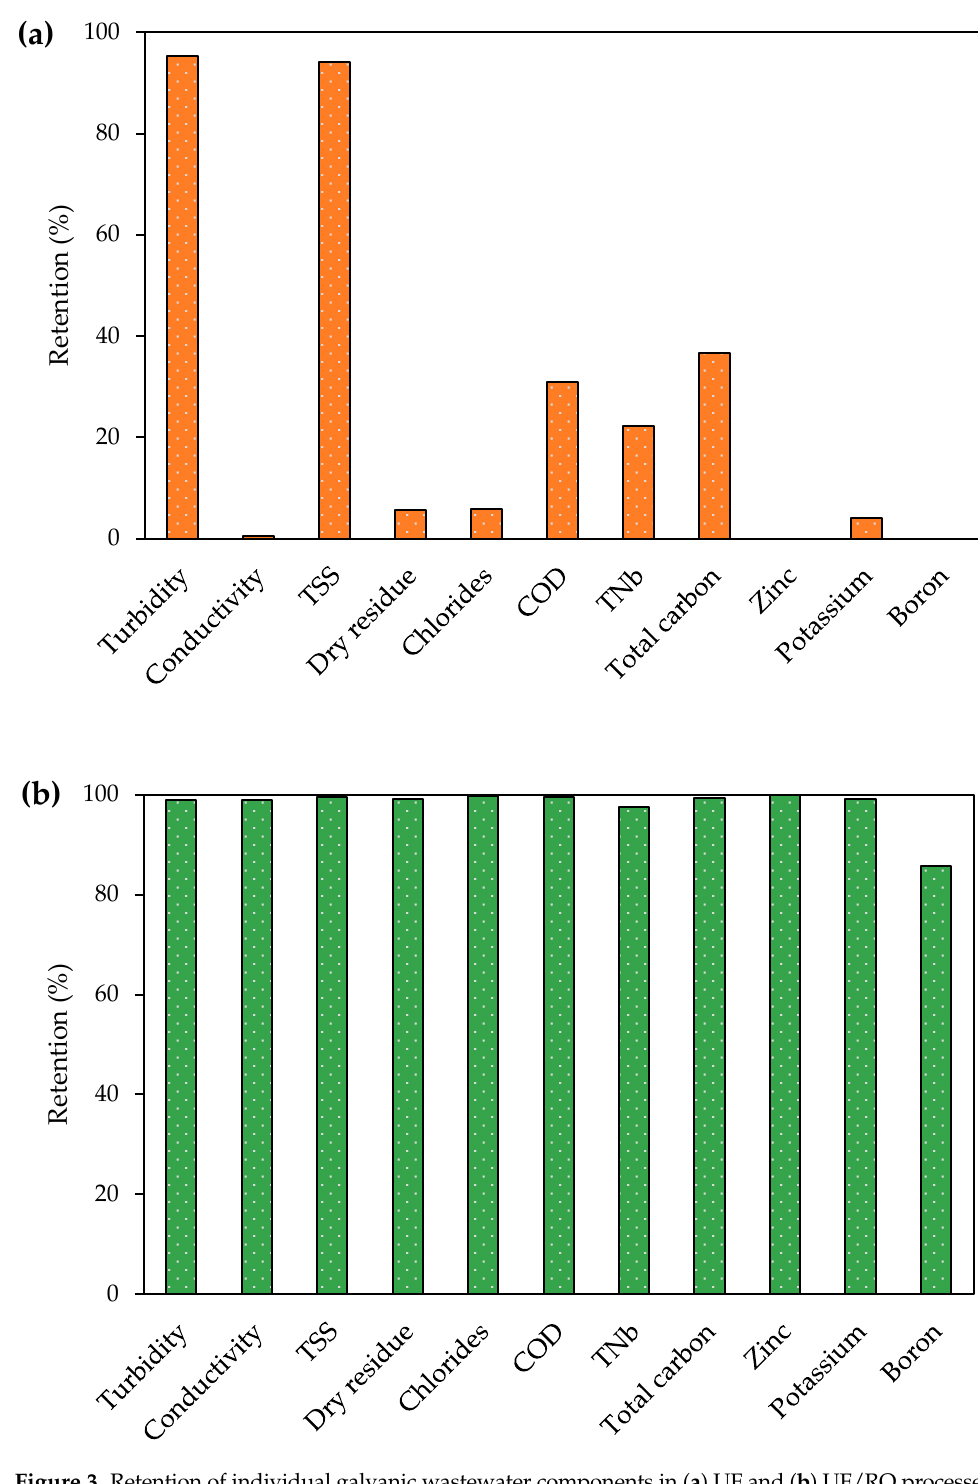
Figure 3. Retention of individual galvanic wastewater components in ( a ) UF and ( b ) UF/RO pro-